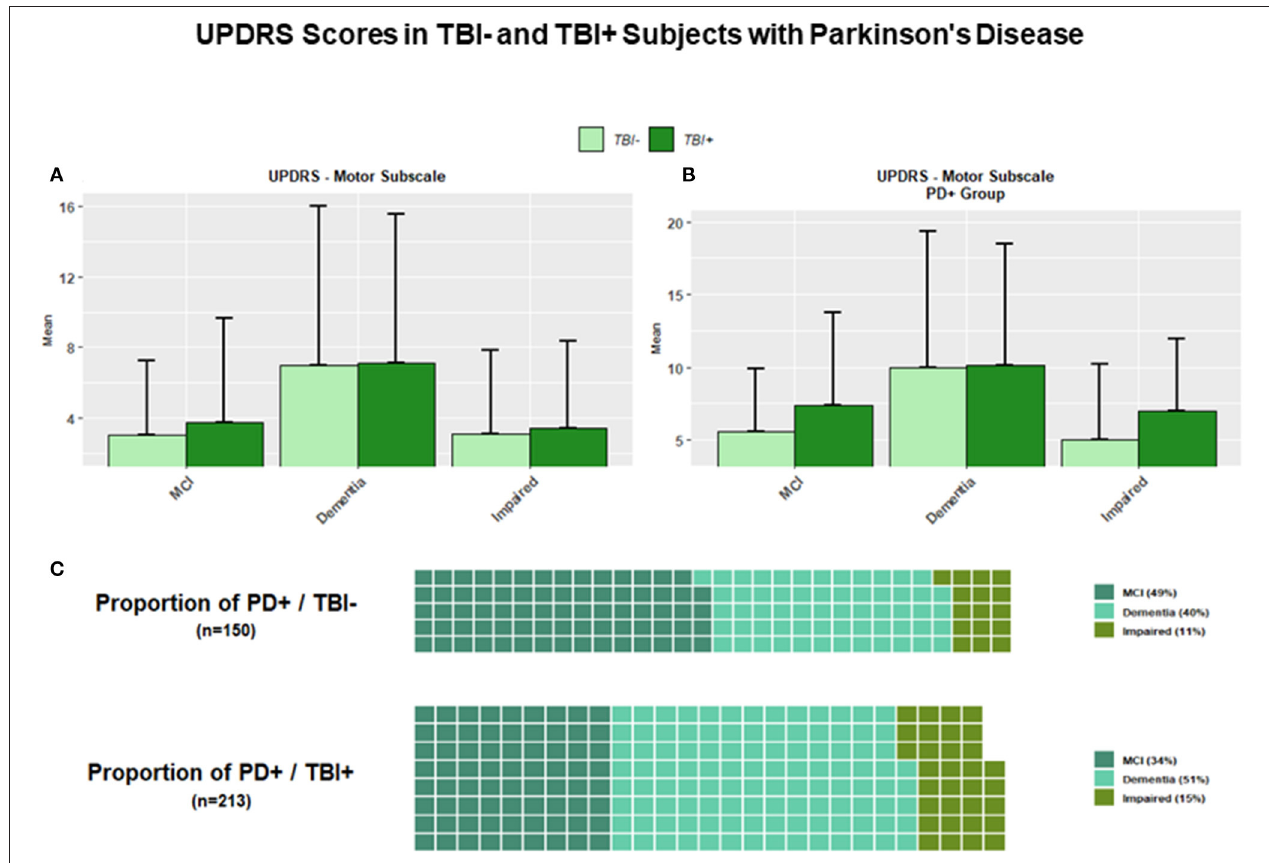
FIGURE 4 | (A) The figure shows bar plots for the UPDRS-Motor scale across all TBI + (subjects with a previous history of TBI at the time of their first cognitive decline assessment) and TBI– (subjects without a previous history of TBI at the time of their first cognitive decline assessment) as clustered by their associated clinical diagnosis at the time of their first cognitive decline assessment. MCI, Mild cognitive impairment, Dementia [including Alzheimer’s disease (AD), Dementia with Lewy bodies (DLB), Progressive supranuclear palsy (PSP), Corticobasal degeneration (CBD), Frontotemporal Dementia (FTD), Vascular dementia (VaD), Traumatic brain Injury (TBI), normal pressure hydrocephalus (NPH), Depression, Cognitive decline due to systematic disease or medical illness], non-AD Impairment (Impaired). (B) The figure shows bar plots for the UPDRS-Motor scale in TBI + and TBI– subjects with a diagnosis of Parkinson’s disease (PD) at the time of their first cognitive decline assessment. Both TBI + /PD/MCI and TBI + /PD/Impaired subjects showed higher mean scores vs. TBI–/PD/MCI and TBI–/PD/Impaired subjects. (C) The two waffle graphs show the counts and corresponding proportions of MCI, Dementia and Impaired subjects with a diagnosis of PD with (TBI + ) and without (TBI–) a history of TBI prior to their first cognitive decline